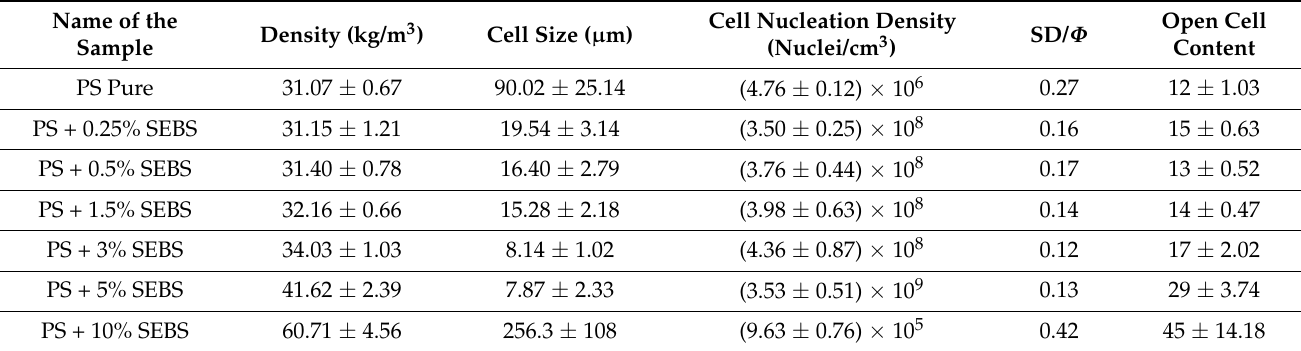
Table 2. Density, cell size, cell nucleation density, homogeneity, and open cell of the foams produced. Name of